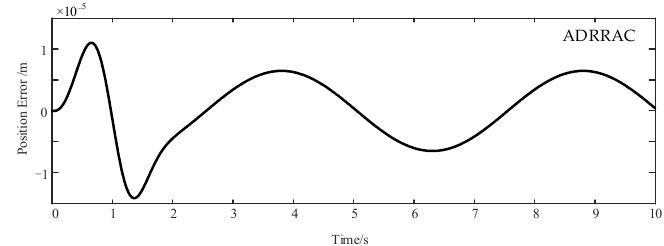
10 Time/s Figure 8. PID Tracking Error of 1 Hz Sinusoidal Signal.